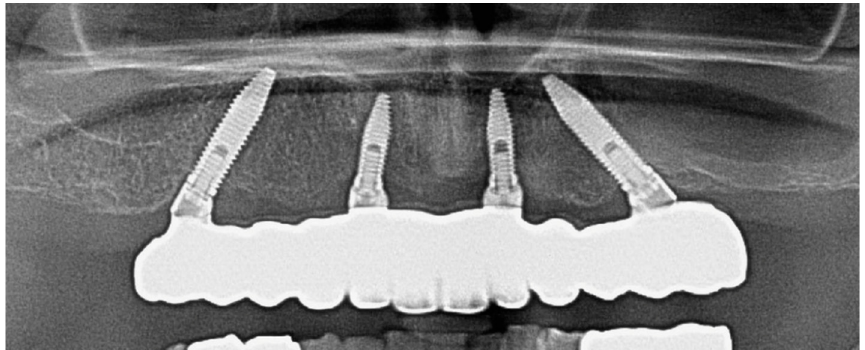
Figure 13. Final orthopantomography.